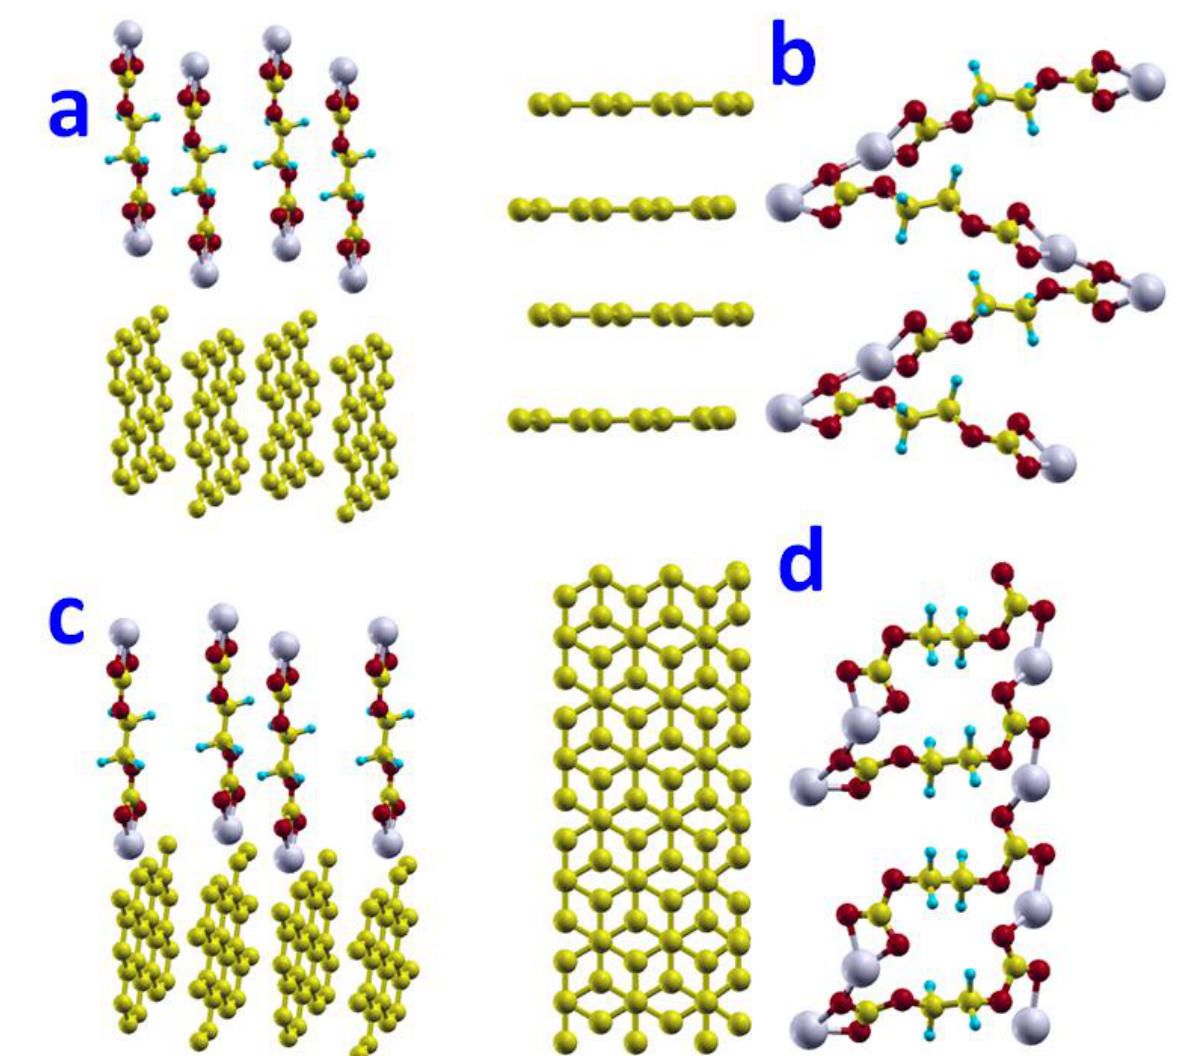
Figure 6. The network of (CH 2 OCO 2 Li) 2 on the zigzag ( a , b ) and armchair ( c , d ) edge surface. Initial structure ( a ) and final structure ( b ) of network of (CH 2 OCO 2 Li) 2 on zigzag edge surface. Initial structure ( c ) and final structure ( d ) of network of (CH 2 OCO 2 Li) 2 on armchair edge